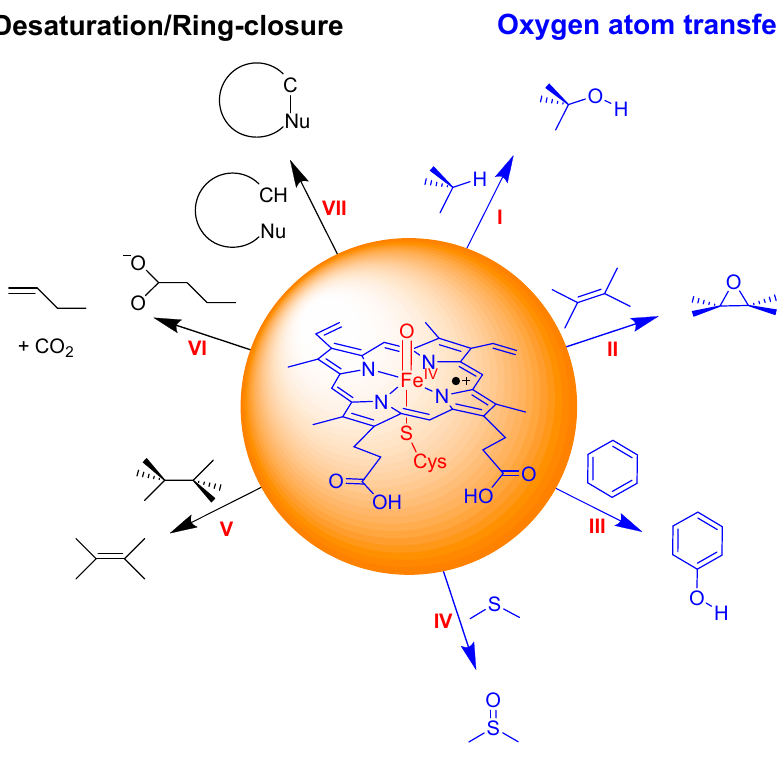
Figure 2. Reaction mechanisms catalyzed by P450 Compound I.